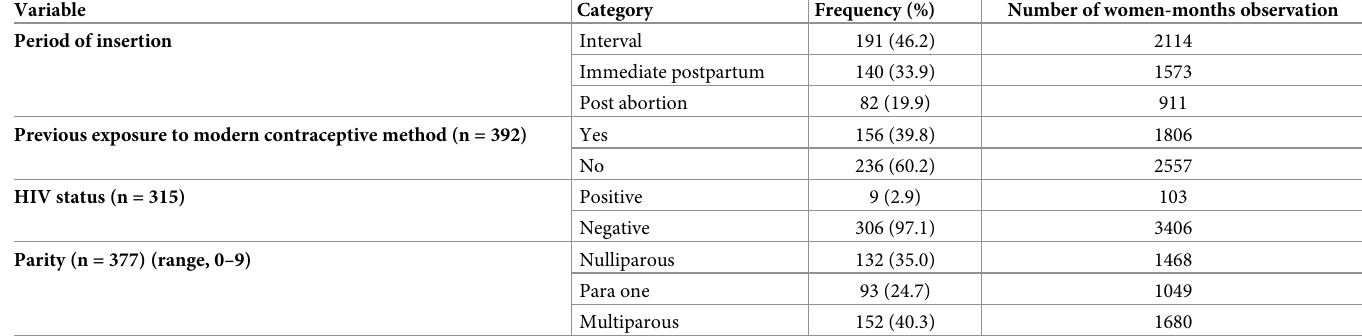
Table 2. Reproductive and contraception related characteristics of the study participants at Ayder comprehensive specialized hospital, Mekelle, Northern Ethiopia, 2016–2017 (n = 413). Variable